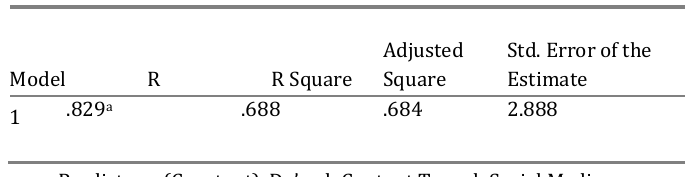
Table 8 Determination Coefficient Calculation Results (r 2